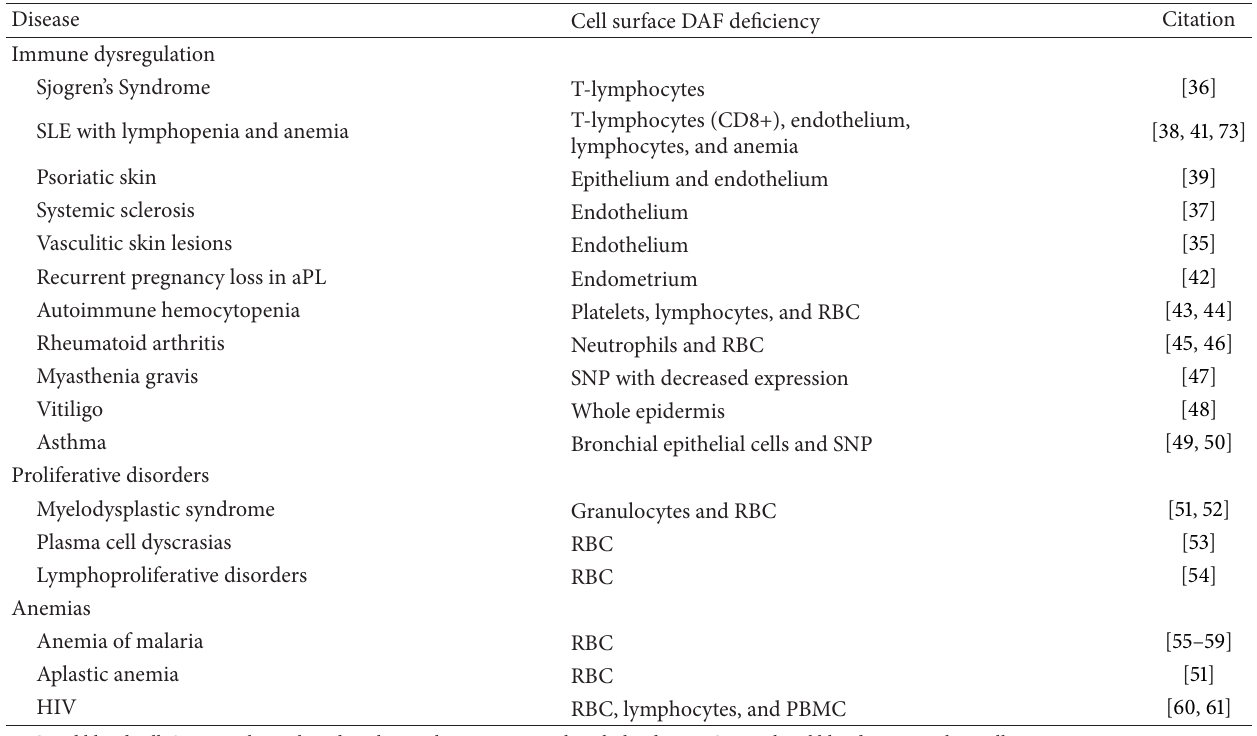
Table 1: Decreased DAF expression in human